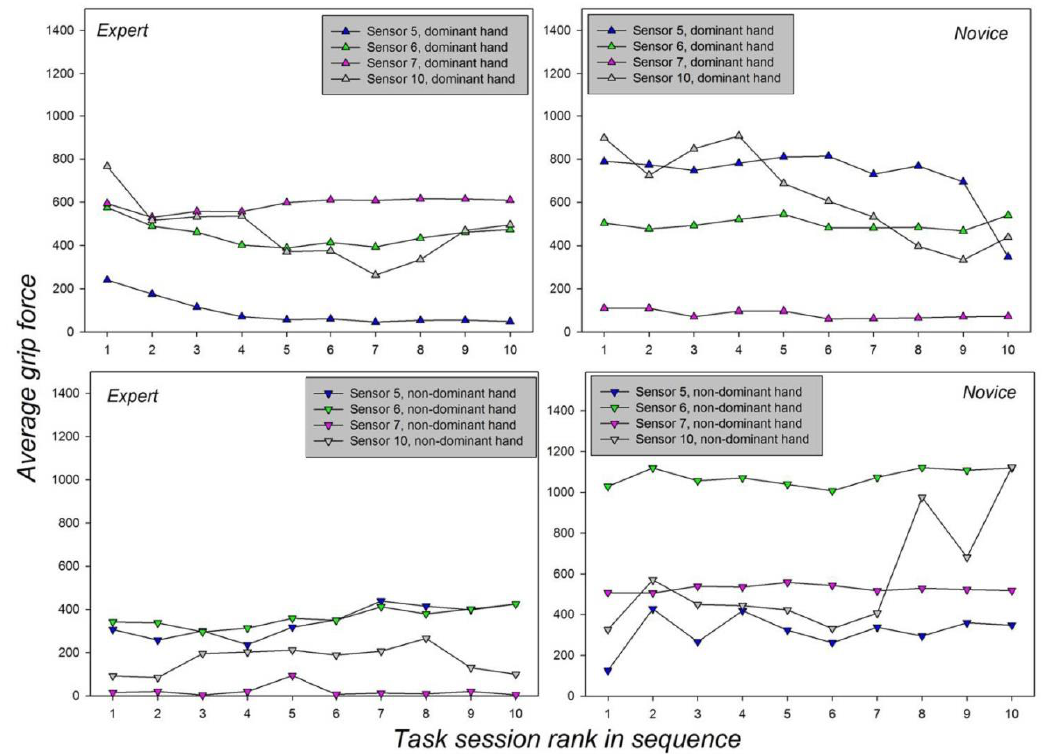
Figure 8. Average grip forces, reflected by sensor output in mV, are plotted as a function of the session and hand factor for the expert ( left ) and the novice ( right ) performing the task with their dominant ( top ) and non-dominant ( bottom ) hands.